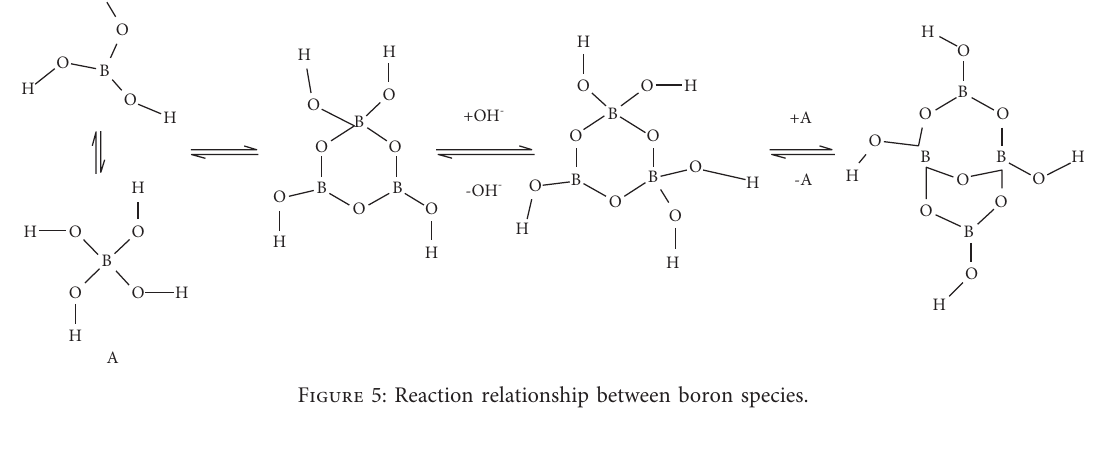
Figure 5: Reaction relationship between boron species.